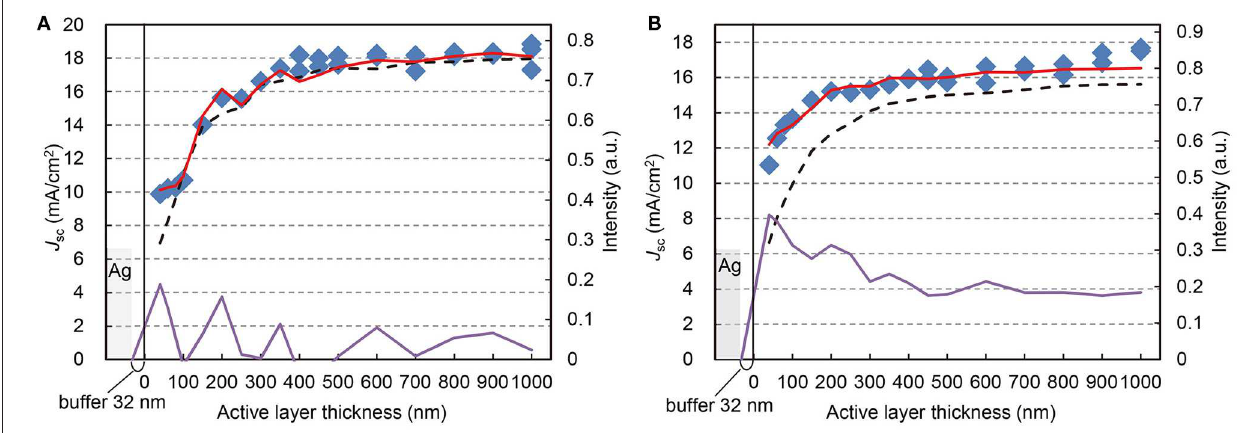
FIGURE 5 | Correspondence of photocurrent and absorbed light intensity. J sc (blue square, referring to left axis) at each ZnPc:C 60 thickness on flat ITO substrate (A) , and textured FTO substrate (B) , corresponding to the normalized intensity of absorbed light with/without reflection at Ag anode (red solid/black broken lines, referring to right axes), calculated from reflectance of actual devices and the square of transmittance of the same active layers, respectively. The amplification rate between the absorbed light intensities with/without reflection is also indicated (purple